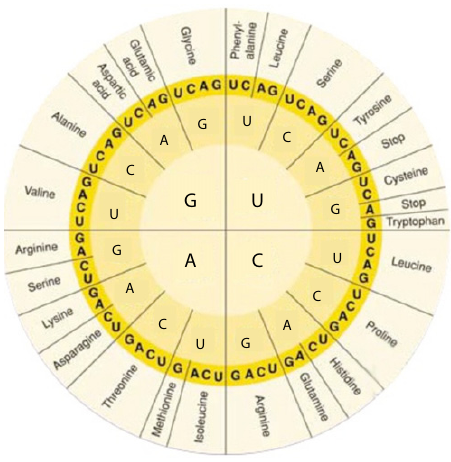
Figure 6. The RNA codon